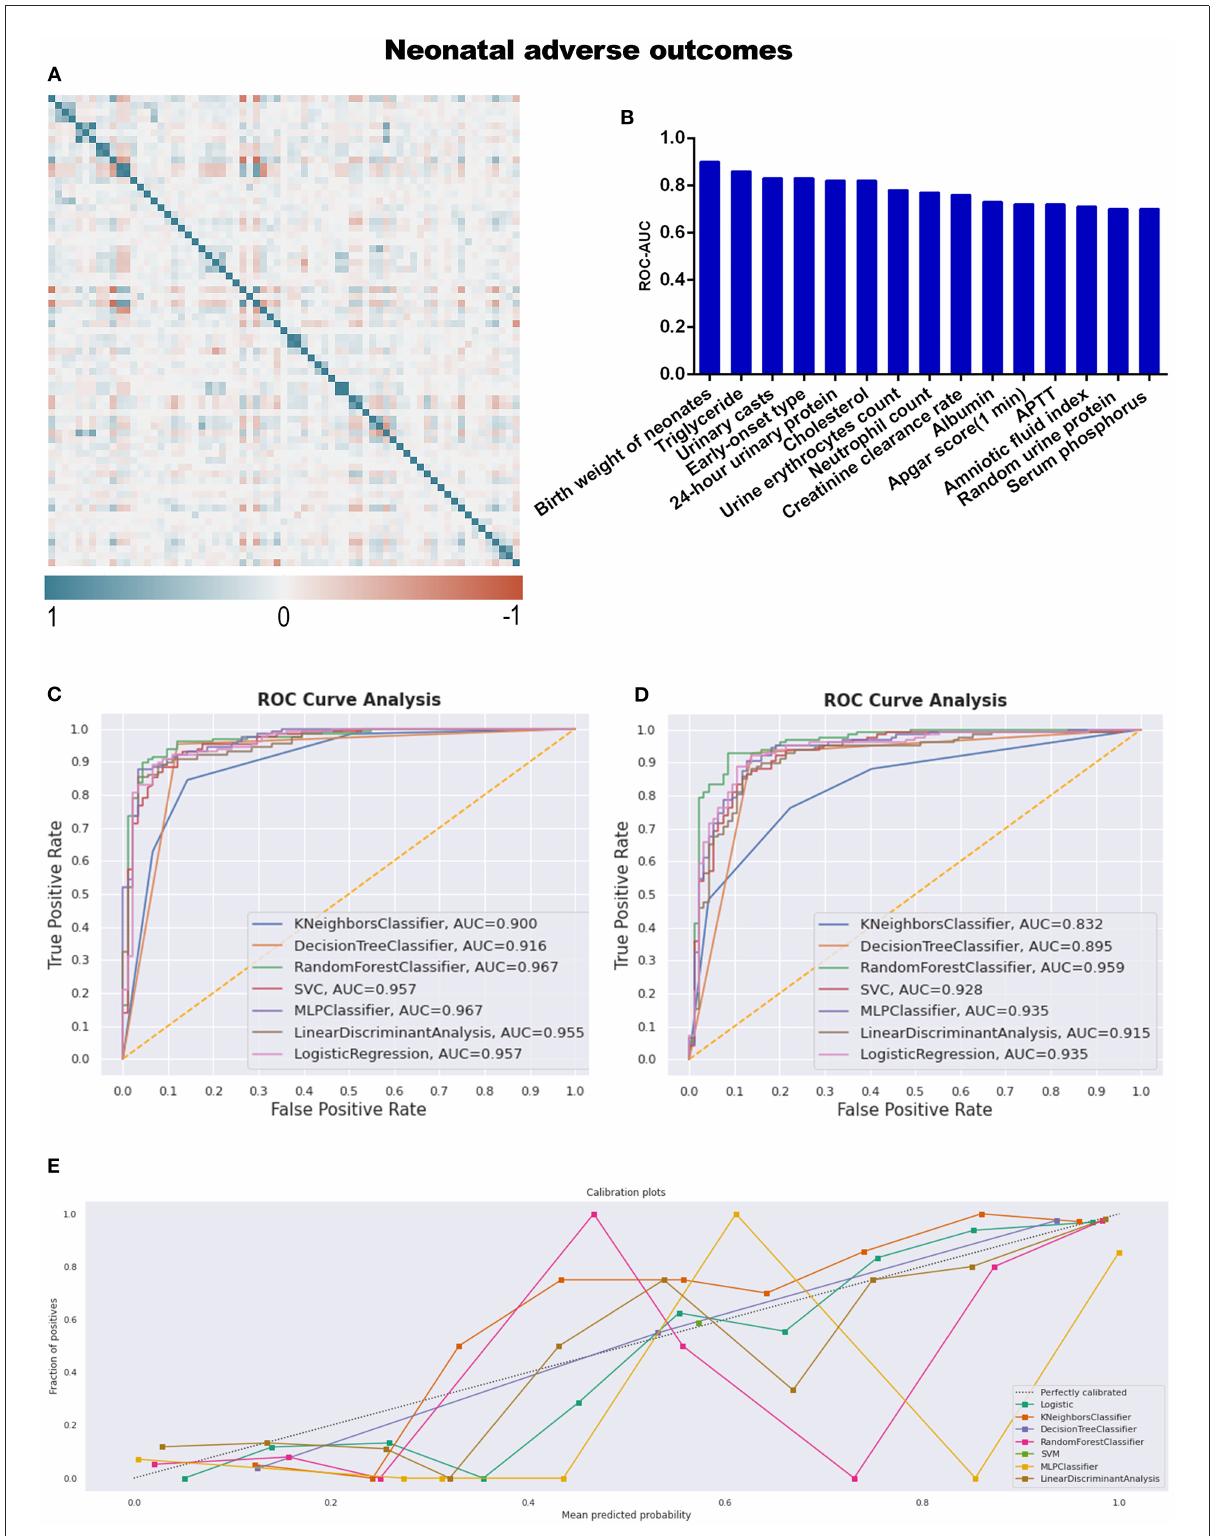
FIGURE5 (A) The generated heat map according to correlation analysis to screen independent variables for adverse events; (B) feature selection of Top 15 adverse outcomes predictive variables according to the value of AUC calculated by DT algorithm; (C) the ROC-AUC values of machine learning and logistic regression predictive models developed from the imputed dataset; (D) the AUC values of models developed from the dataset without imputation; (E) the calibration curve generated from the models developed from imputed dataset. Referring to an adverse neonatal